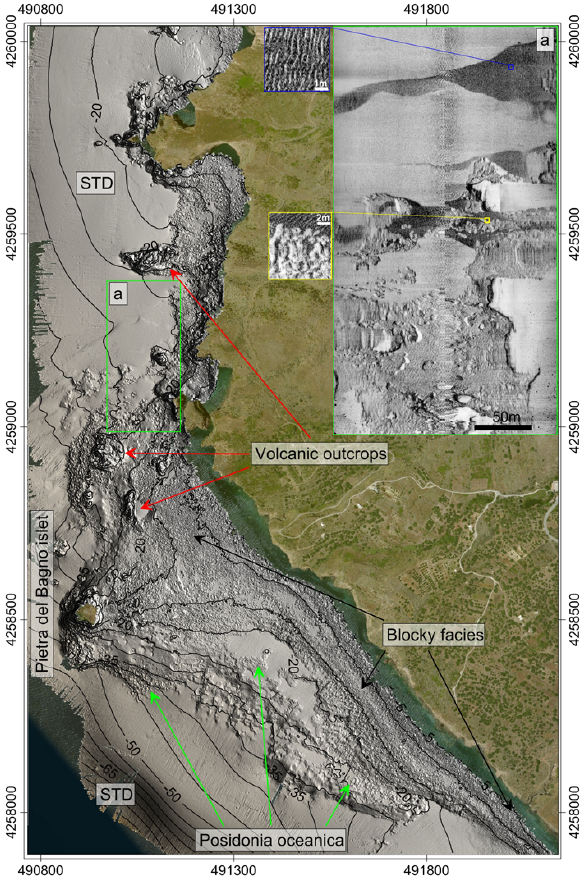
Figure 8. Shaded relief of the western sector of Lipari Island show- ing: i) volcanic outcrops, ii) blocky facies parallel to the coastlines, and iii) Posidonia oceanica meadows. In the inset an example of a multibeam backscatter image is shown (dark grey tones indicate high-backscatter areas). Upper and lower insets show enlarged de- tails of sand ripples and Posidonia oceanica,